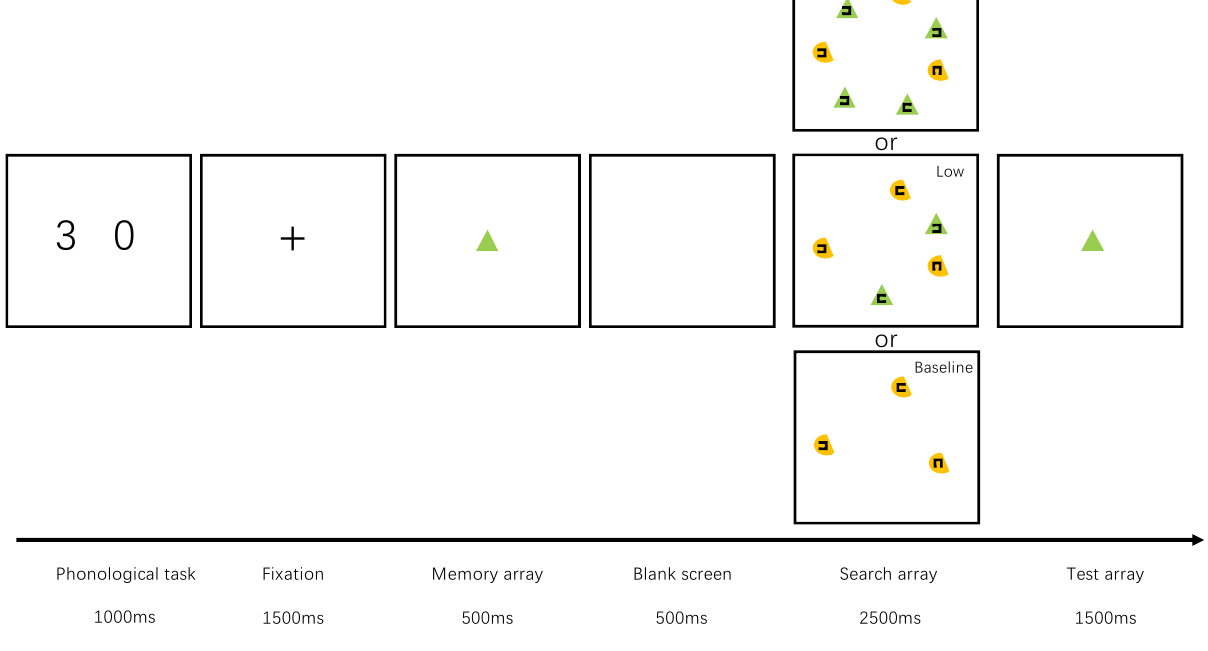
Figure 1. Trial structure of the dual-task paradigm. In this example, there are two kinds of items (non-target items and target items) in the search array. The non-target items share the same color and shape as the memory item and occur only in the memory distraction trials (High or Low) but not in the Baseline trials. The target appeared only inside the target items. The paradigm consisted of three different types of trials.